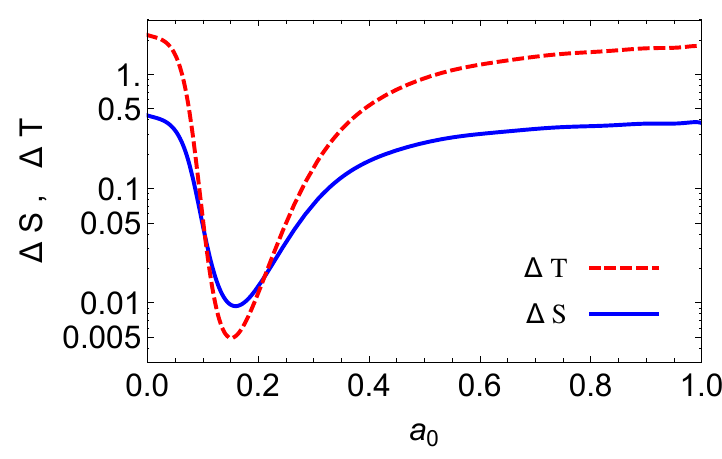
Figure 1 . Contribution to the S and T parameters from the gauge KK modes as a function of a 0 . We have considered b 0 = 2 and m KK = 2